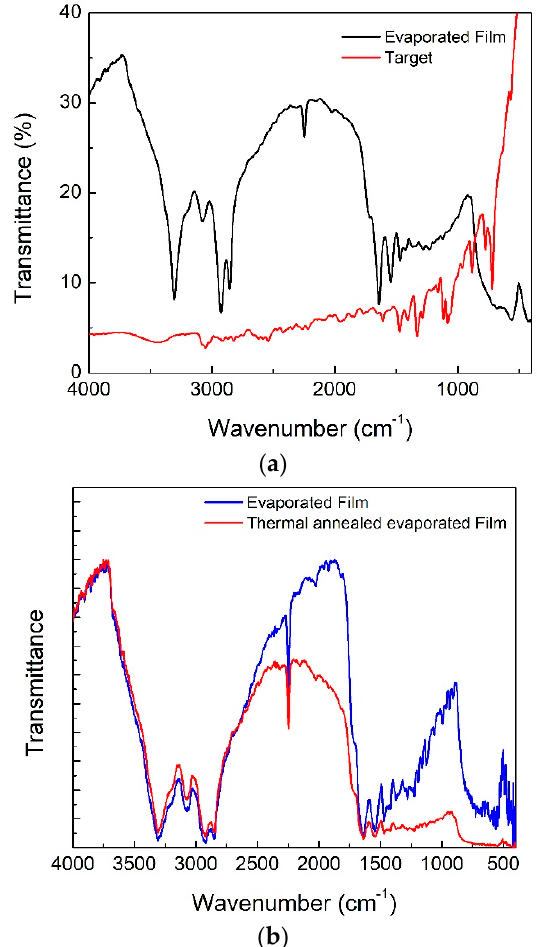
Figure 5. FTIR spectra of ( a ) the fabricated target and evaporated film and ( b ) the evaporated and thermal annealed